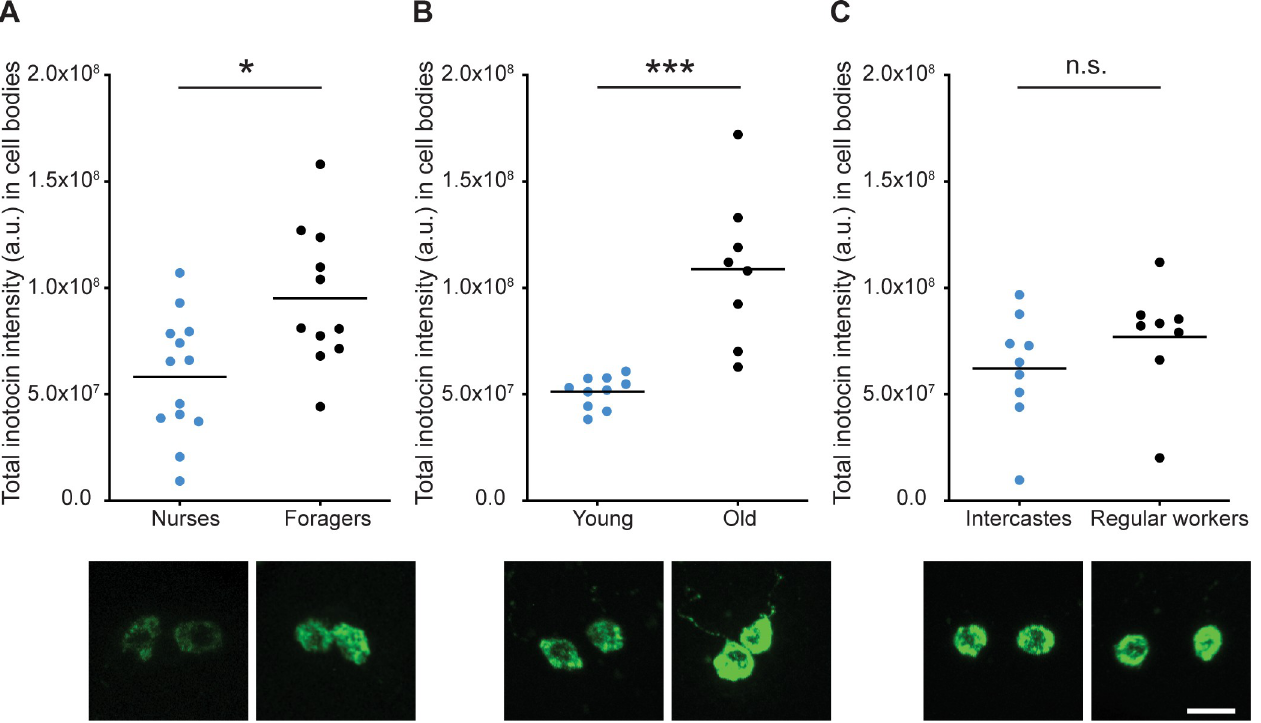
Fig 3. Foragers and old ants have higher levels of inotocin in the brain. (A) Among aged-matched ants, foragers have more inotocin than nurses inside inotocinergic cell bodies ( n � 11; unpaired t test, � p = 0.022, Bonferroni corrected; measured during the brood care phase). (B) Old ants have more inotocin in cell bodies than young ants ( n � 8; unpaired t test, ��� p = 0.0003, Bonferroni corrected; measured during the brood care phase). (C) No difference in inotocin levels was observed between intercastes and age-matched regular workers ( n � 8; unpaired t test, p = 0.785, Bonferroni corrected; measured during the brood care phase). Levels of inotocin were calculated from anti-inotocin (neurophysin domain) stained brains by measuring the total intensity of all fluorescent voxels from each image stack. Representative cell body confocal images are displayed under each experimental condition labeled in the graphs. The scale bar represents 10 μ m. The data underlying this figure can be found in S2